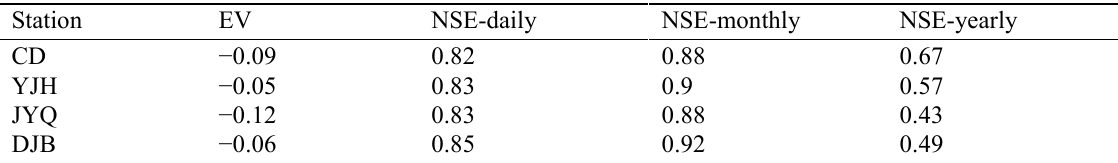
Table 4 The NSE and error of volume at the four hydrological stations by using optimized parameters at daily, monthly and yearly scale. The values of EV are the same at all three time scales. Station EV NSE-daily NSE-monthly NSE-yearly CD − 0.09 0.82 0.88 0.67 YJH − 0.05